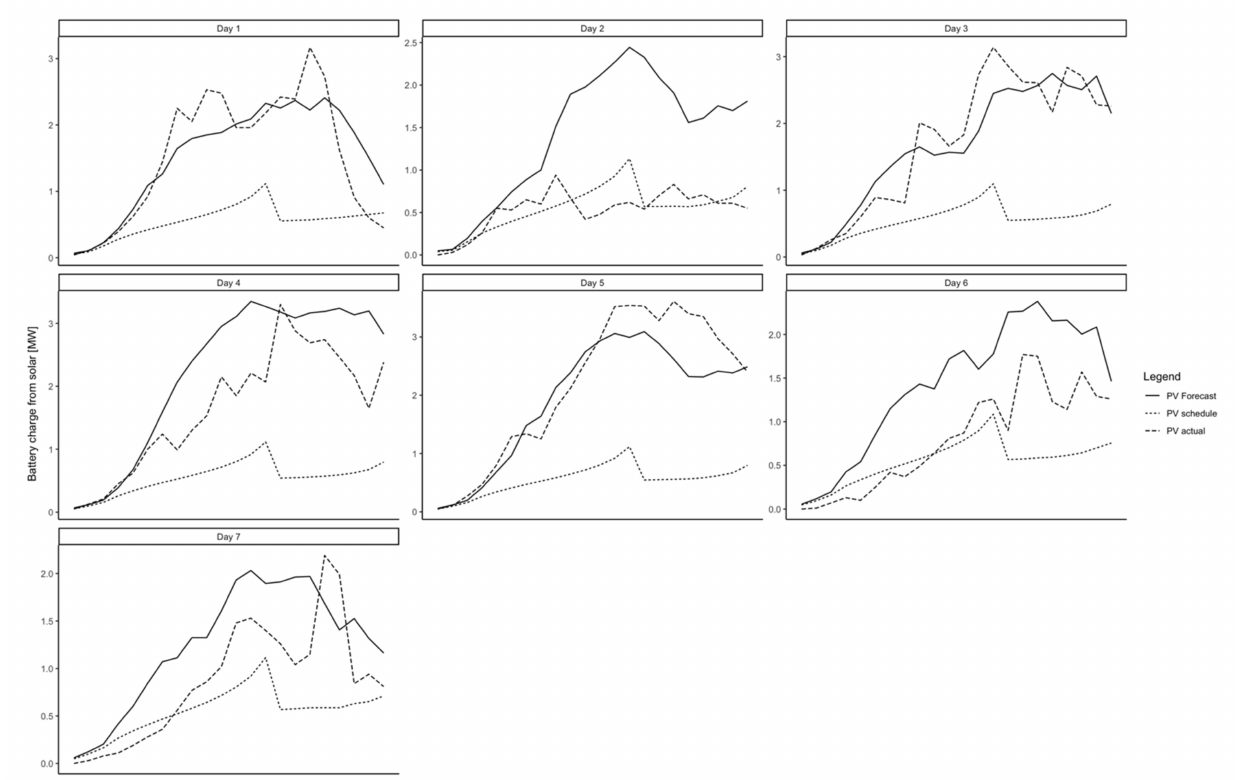
Figure 4. Solar forecasts, actuals and charge profile for all 7 days in Round